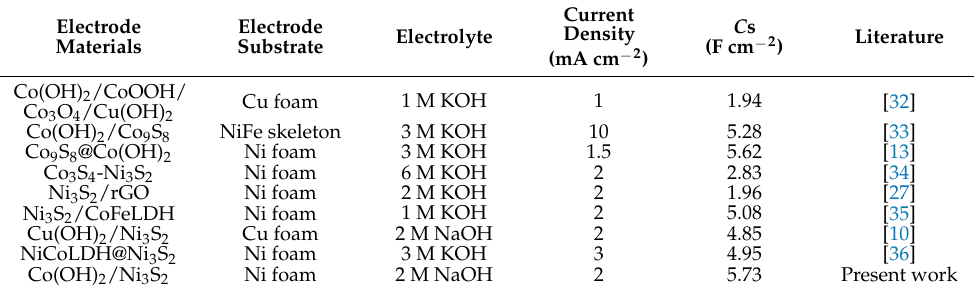
Table 1. Comparison of C s of Cu(OH) 2 /Ni 3 S 2 with reported in the literatures. Electrode Electrode Materials Substrate